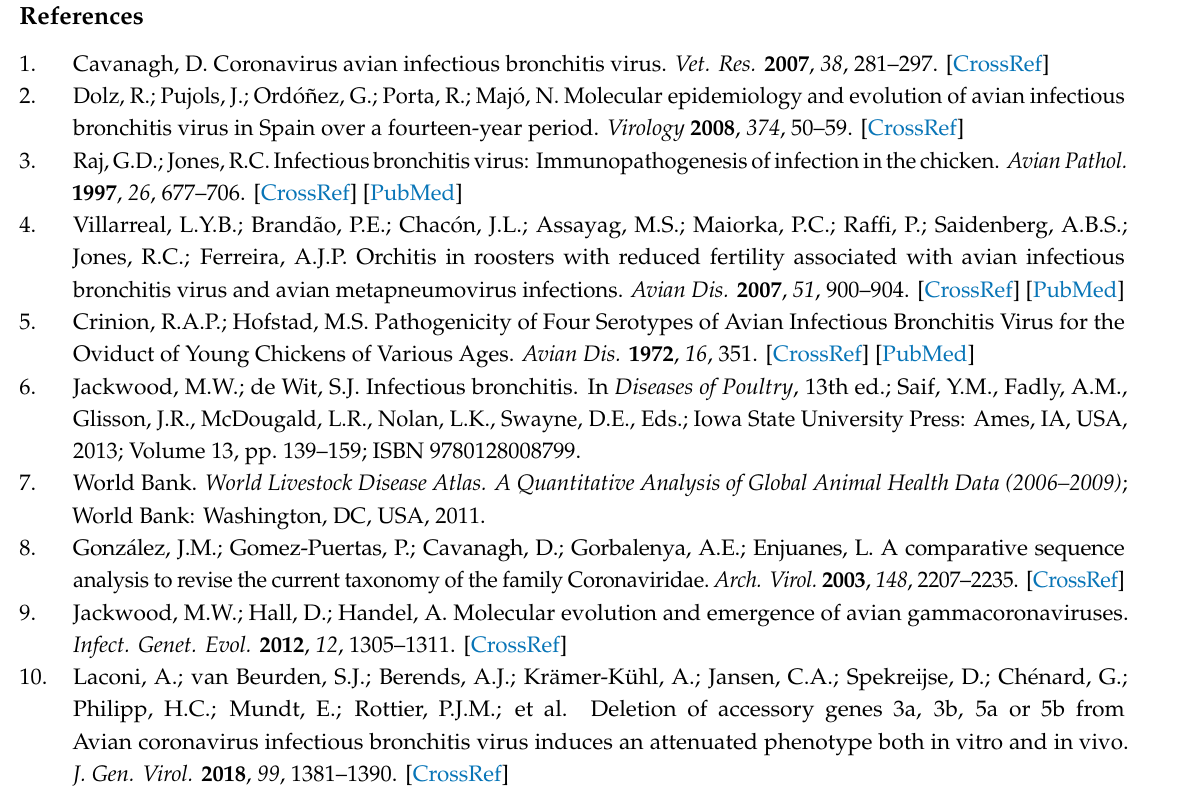
Figure S1: Phylogenetic tree reconstructed based on a broad dataset of IBV strains. The Ethiopian sequences have been colored in red, while the corresponding clade is highlighted in